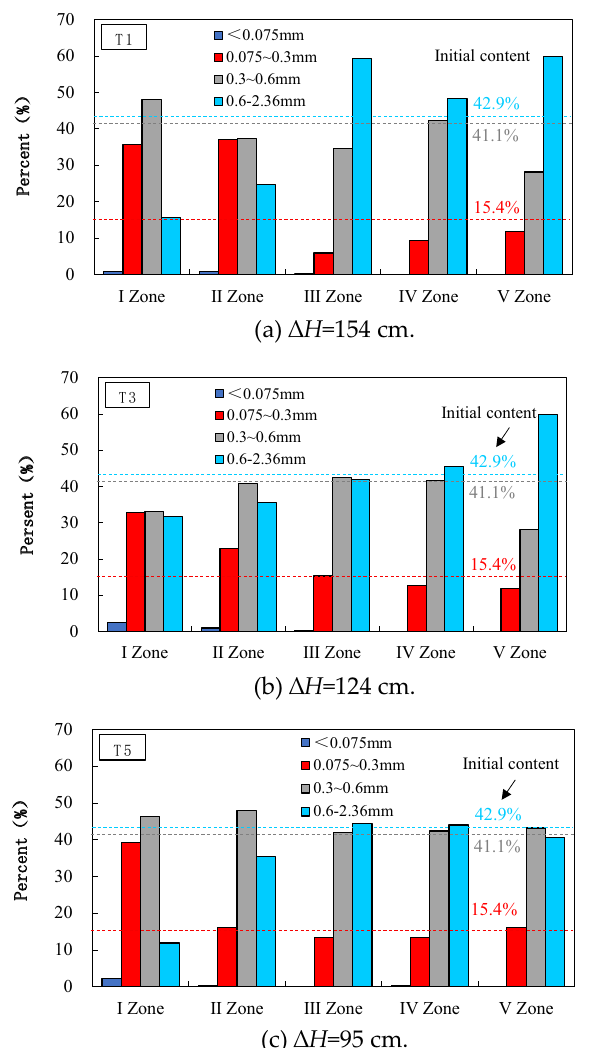
Figure 7. Variation of soil particles with hydraulic head in different sand